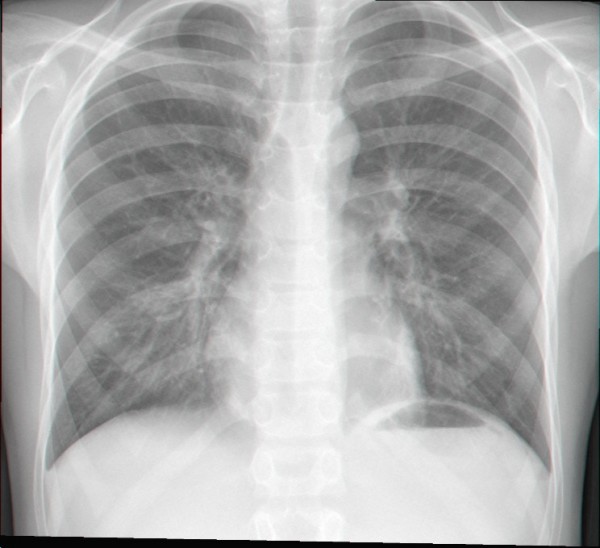
Chest radiography.